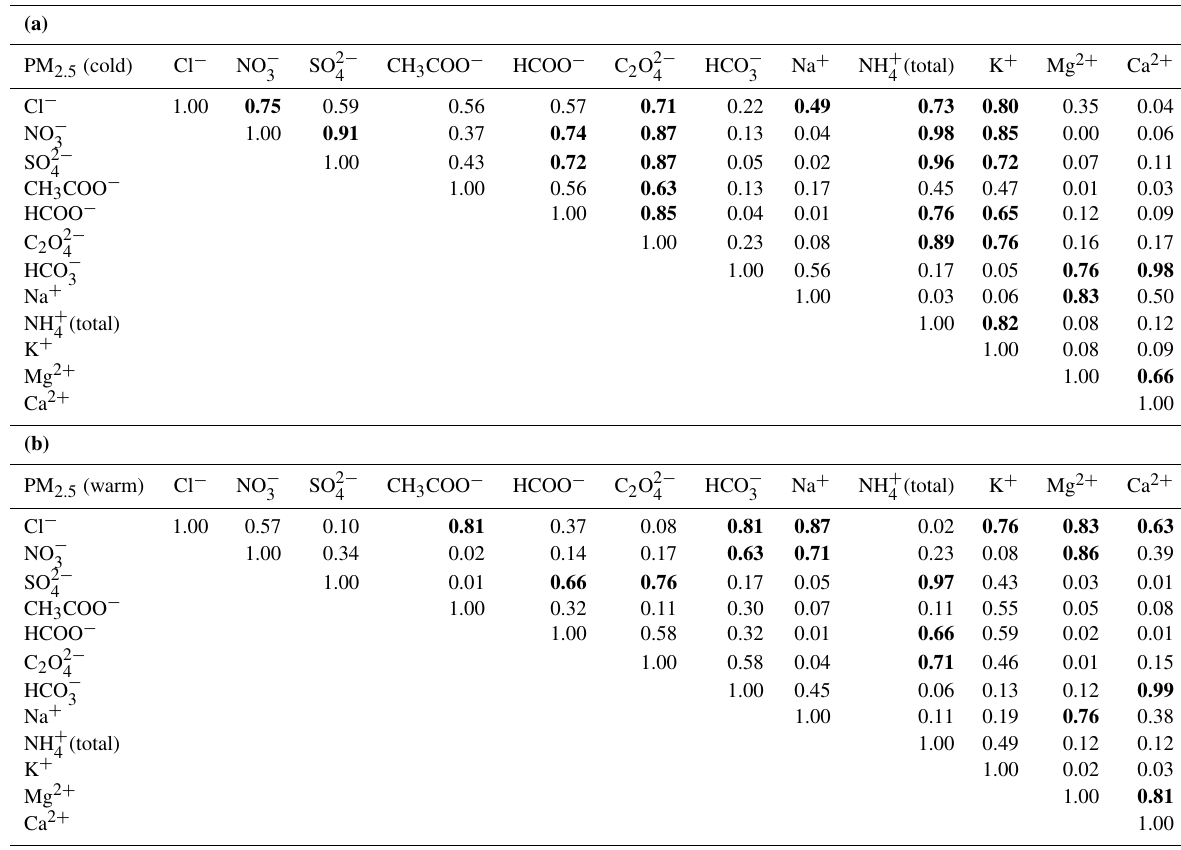
Table 4. Correlation matrix (Pearson coefficients) for major ionic species (Cl − , NO − NH + (total), K + , Mg 2 + , Ca 2 + ) in fine aerosol particles from Iasi, north-eastern Romania, for both cold (a) and warm (b) seasons. Bold font 4 reflects statistical significant correlation at the 99.9% confidence